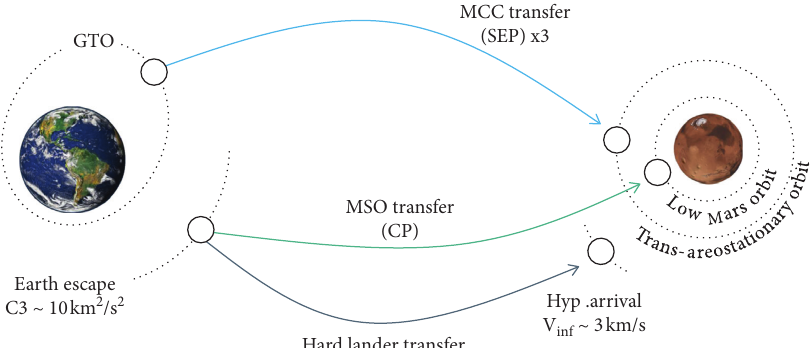
Figure 4: Overview of the propulsion architecture options considered for study. Solar electric propulsion (SEP) and chemical propulsion (CP) transfers are considered to reach low Mars orbit (LMO) and specific areosynchronous (AEO) orbits such as Trans-Areostationary